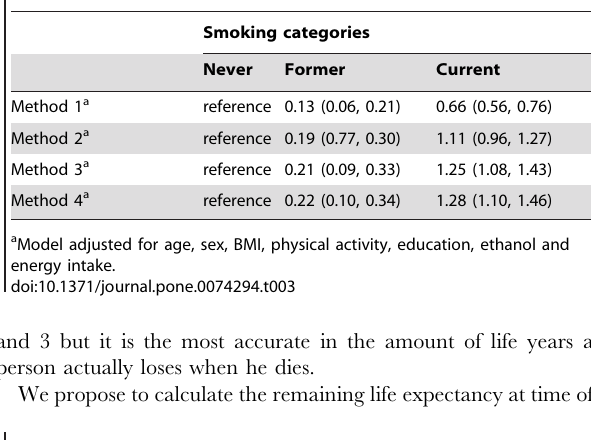
Table 4. Sensitivity analysis for the relationship of smoking status with Disability-Adjusted Life Years (DALYs) in 33,507 EPIC-NL participants a .